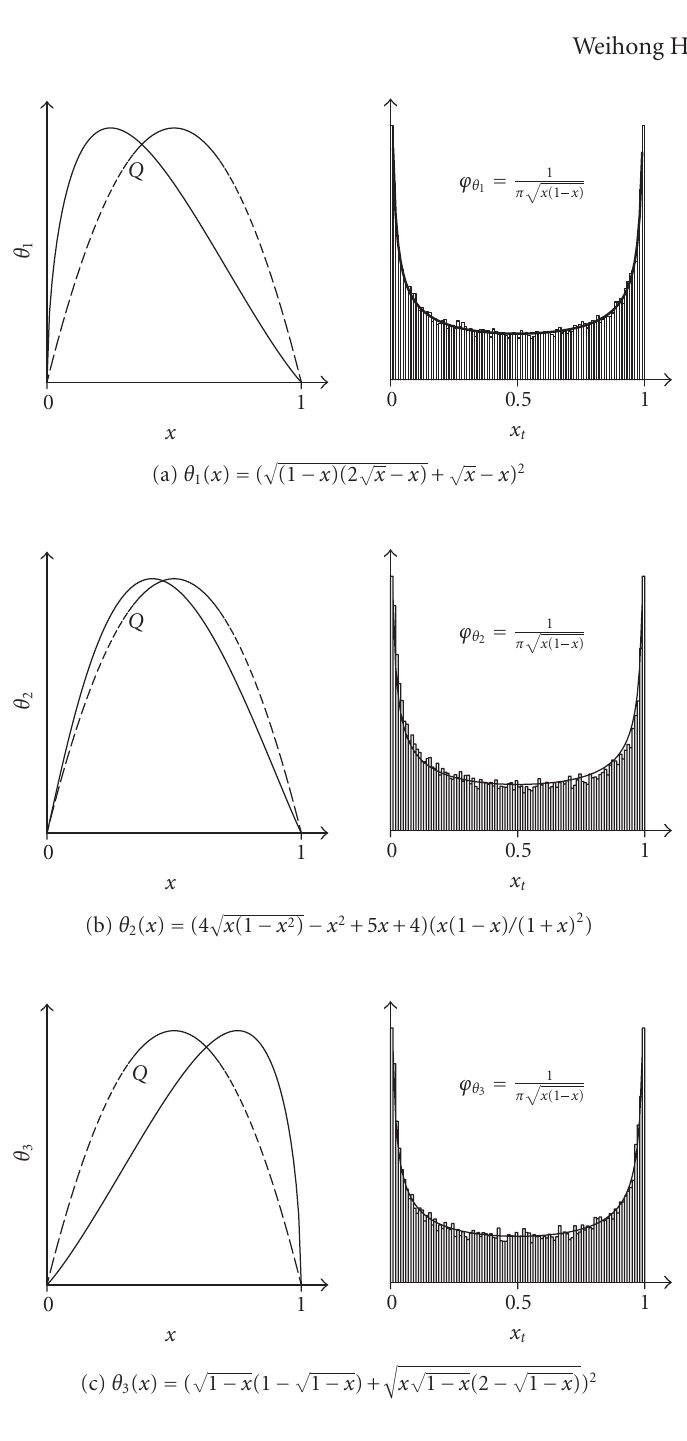
Figure 3.4. SCC maps preserving the same symmetric